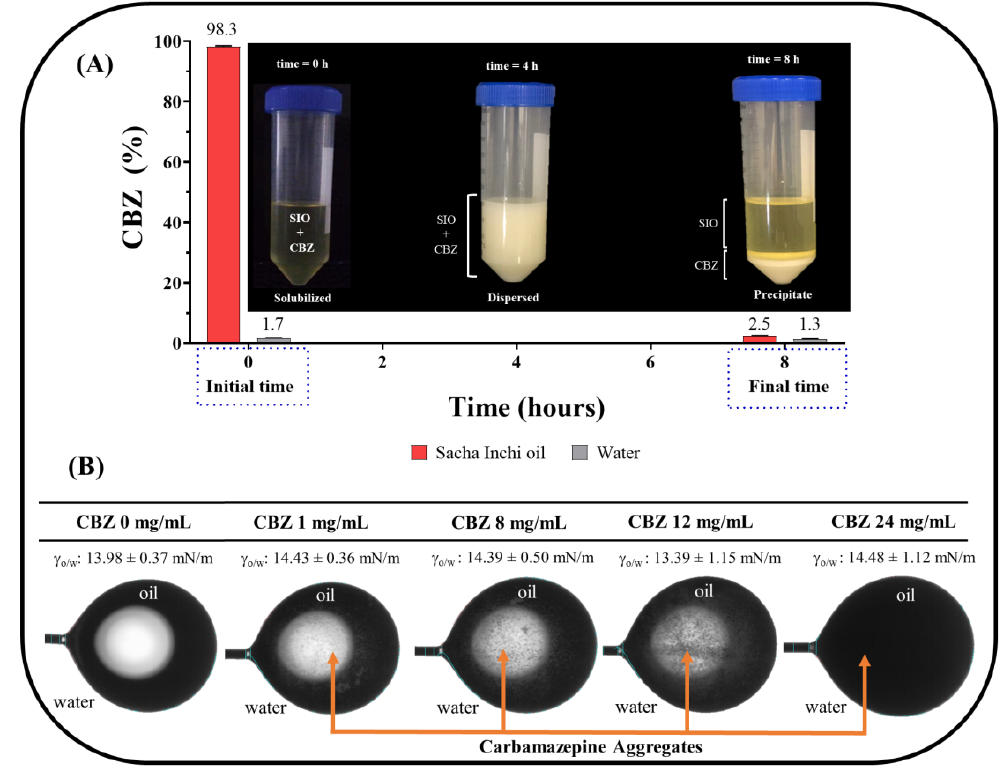
Figure 2. SIO/water interface physicochemical characterization. (A) SIO/water partition of CBZ with Figure 2. SIO / water interface physicochemical characterization. ( A ) SIO / water partition of CBZ with respect to time. (B) Effect of CBZ concentration inside oil droplets on interfacial tension. respect to time. ( B ) E ff ect of CBZ concentration inside oil droplets on interfacial